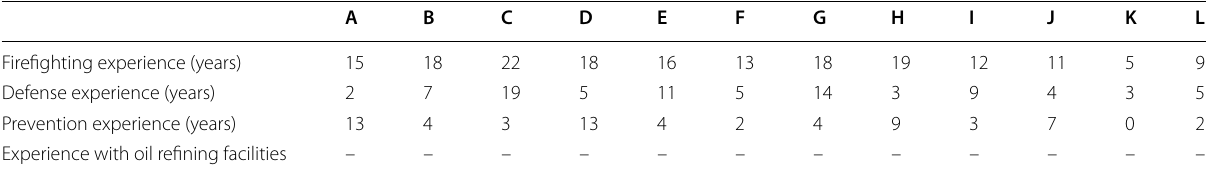
Table 5 Participants’ experience in firefighting, defense, prevention, and oil refining